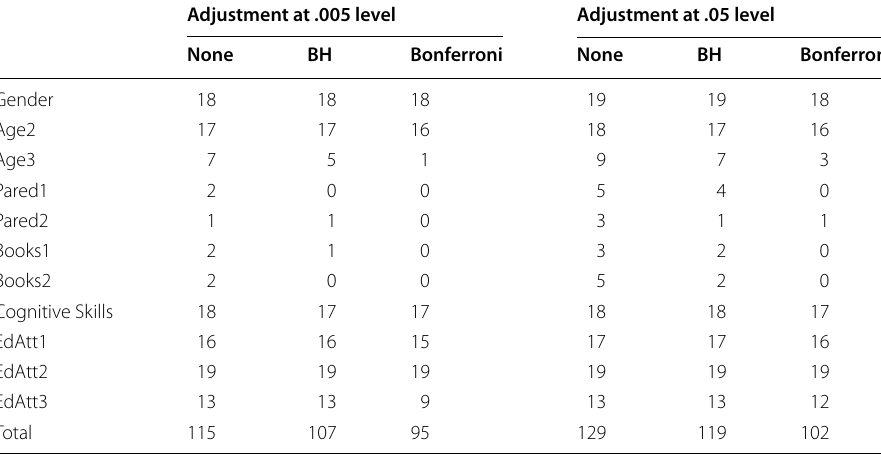
Table 7 Counts of discoveries for M3 coefficients, by variable [Q4] Adjustment at .005